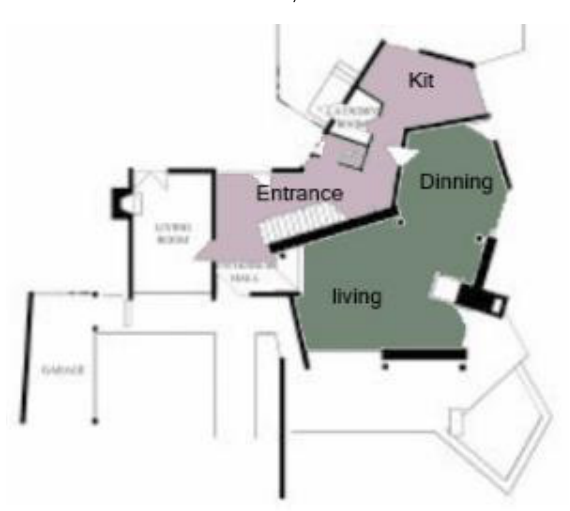
Figure 17. Macit Ferdi House, Open Plan (D.Celik, without date).